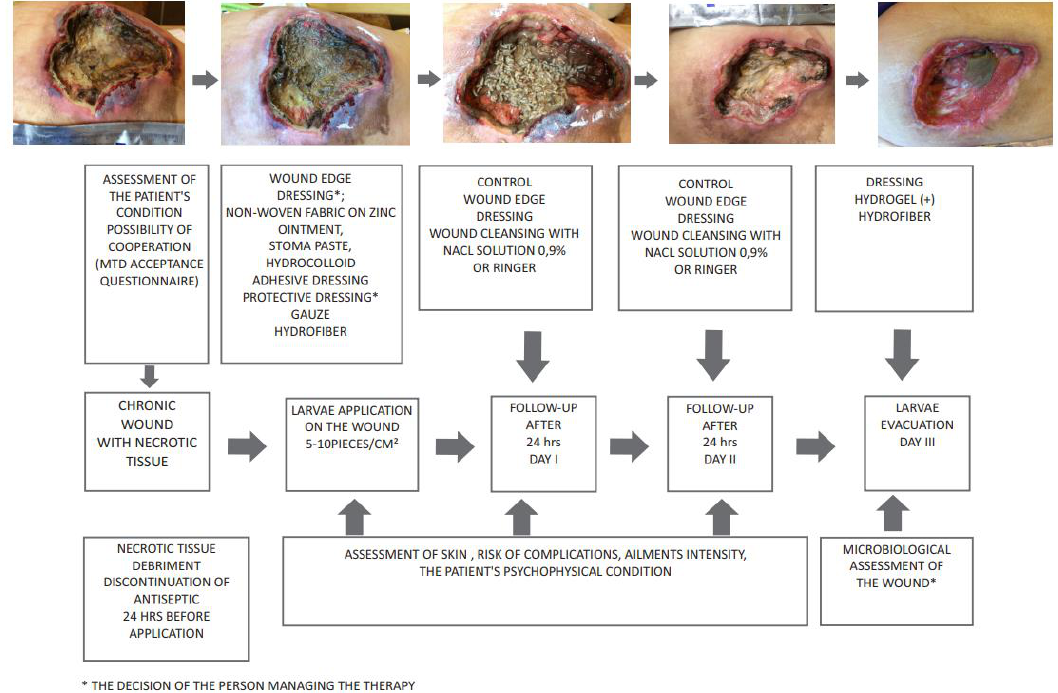
Figure 2. Algorithm of preparing and conducting therapy with Lucilia sericata larvae in a group [22].